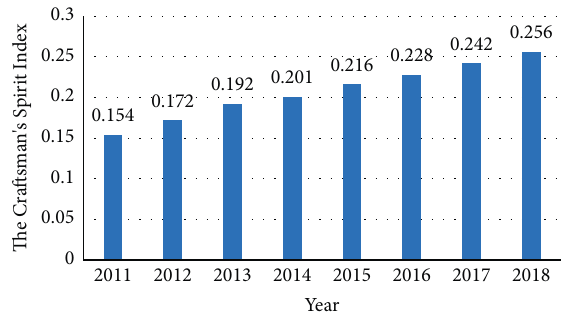
Figure 2: The trend of the average value of craftsman’s spirit in the national construction industry from 2011 to 2018.